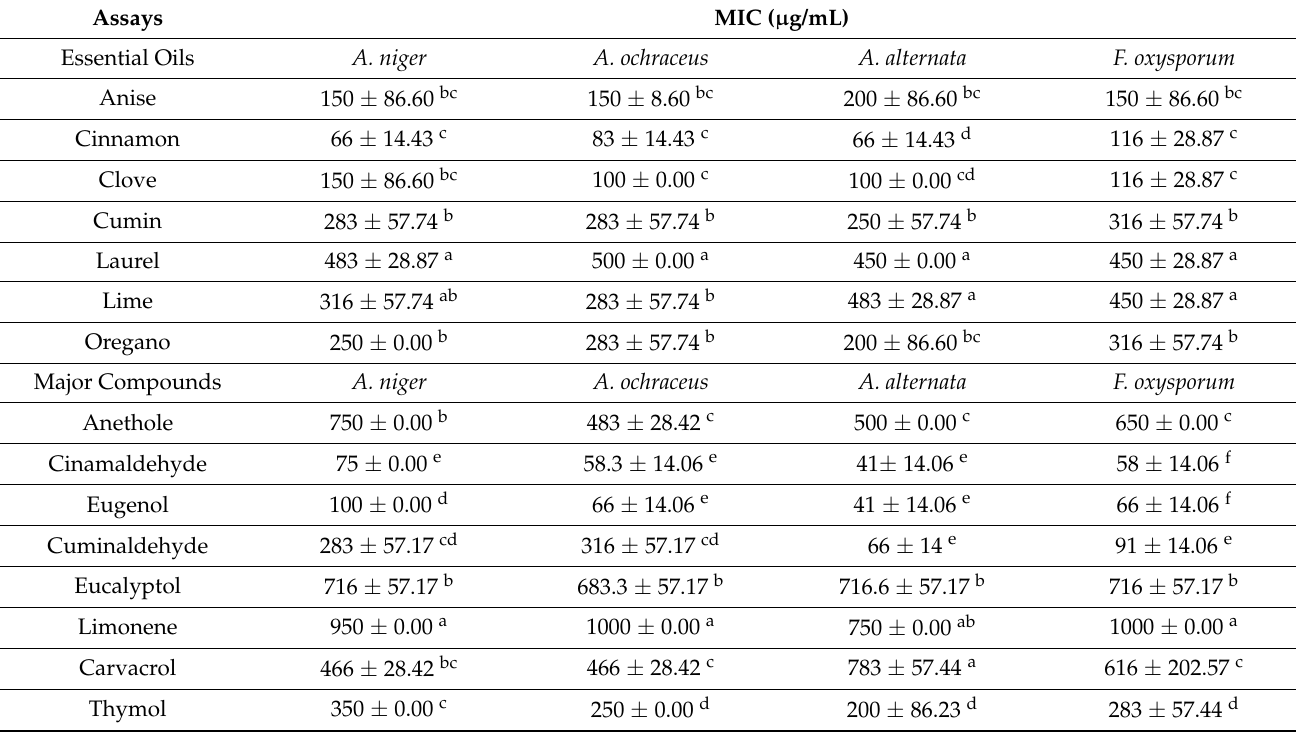
Table 3. Antifungal activity of essential oils and their majority